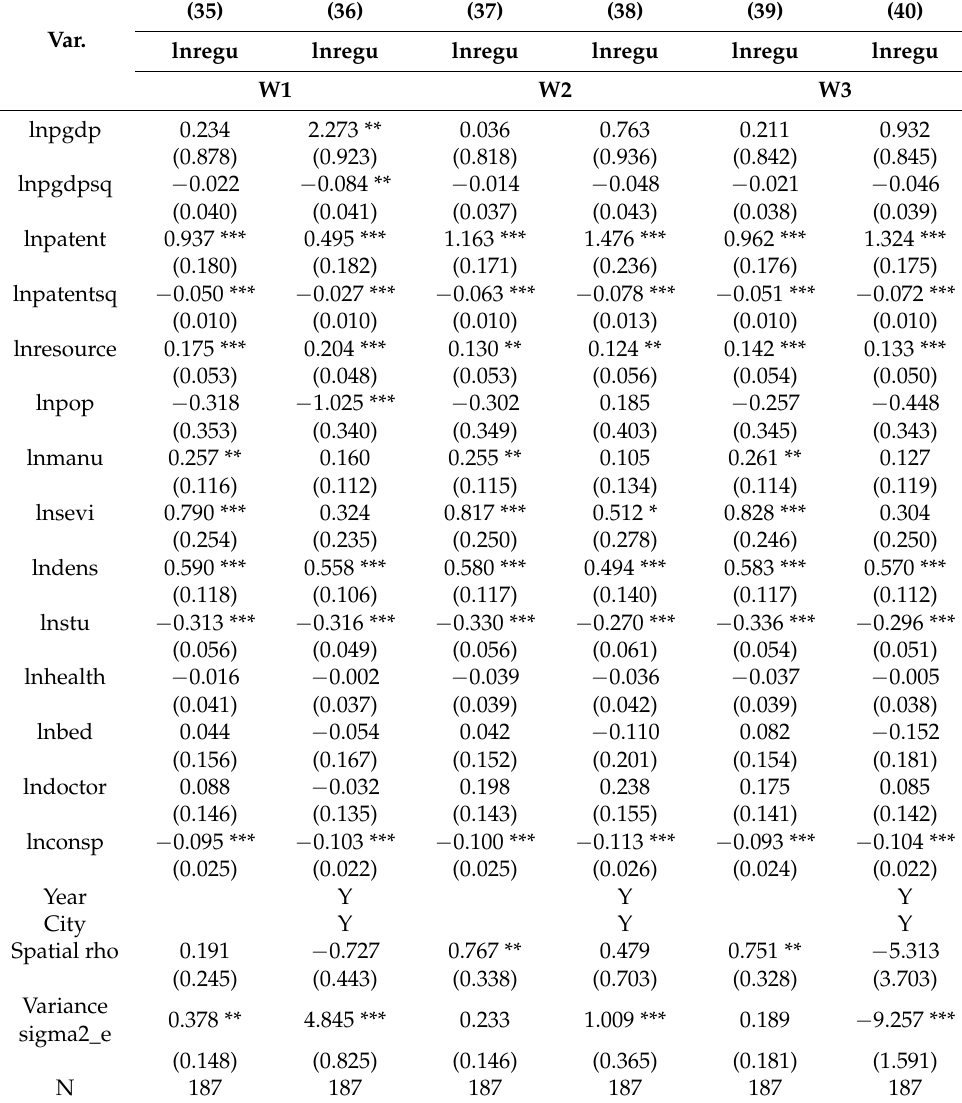
Table 7. The effect